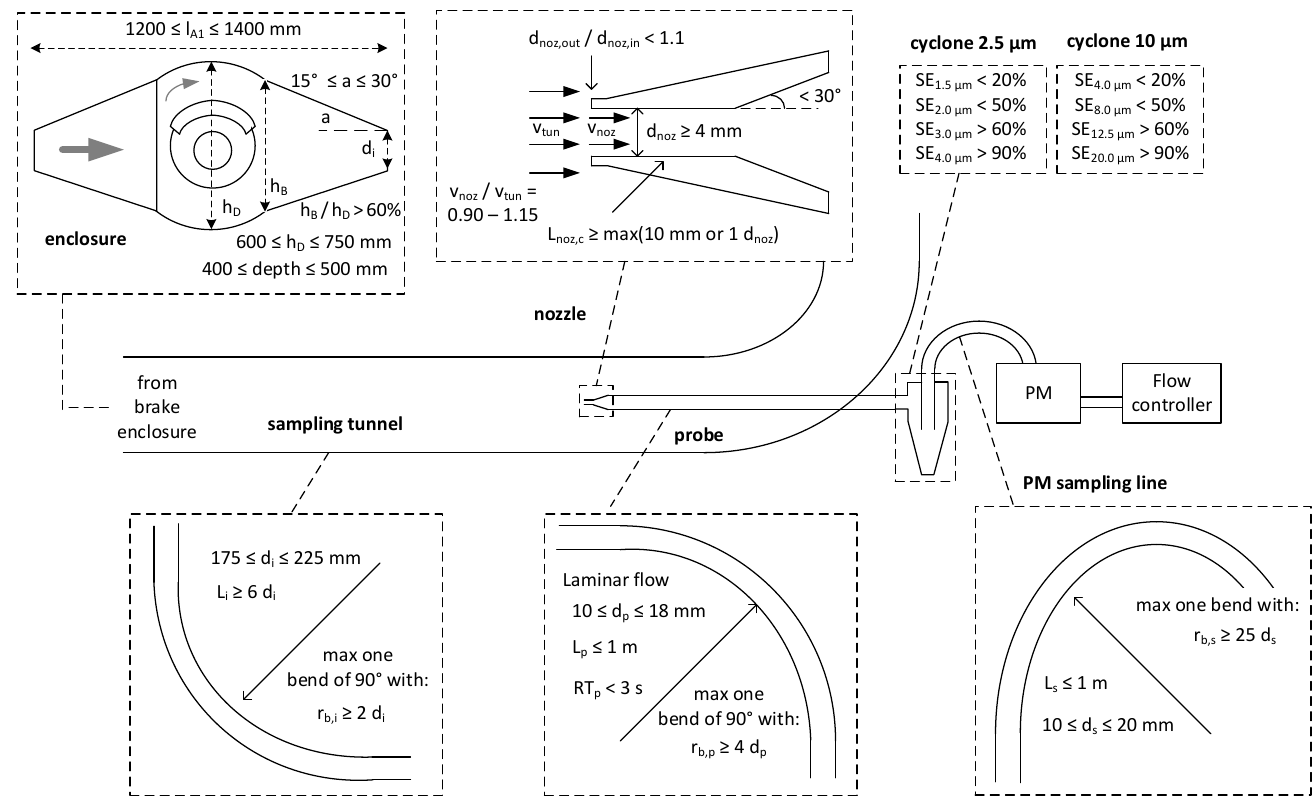
Figure 2. Overview of the technical requirements of the particulate matter (PM) setup. d = diameter; HEPA = high efficiency particle air filter; L = length; noz = nozzle; tun = tunnel; R = radius; RT = residence time; SE = sampling efficiency; v = velocity.